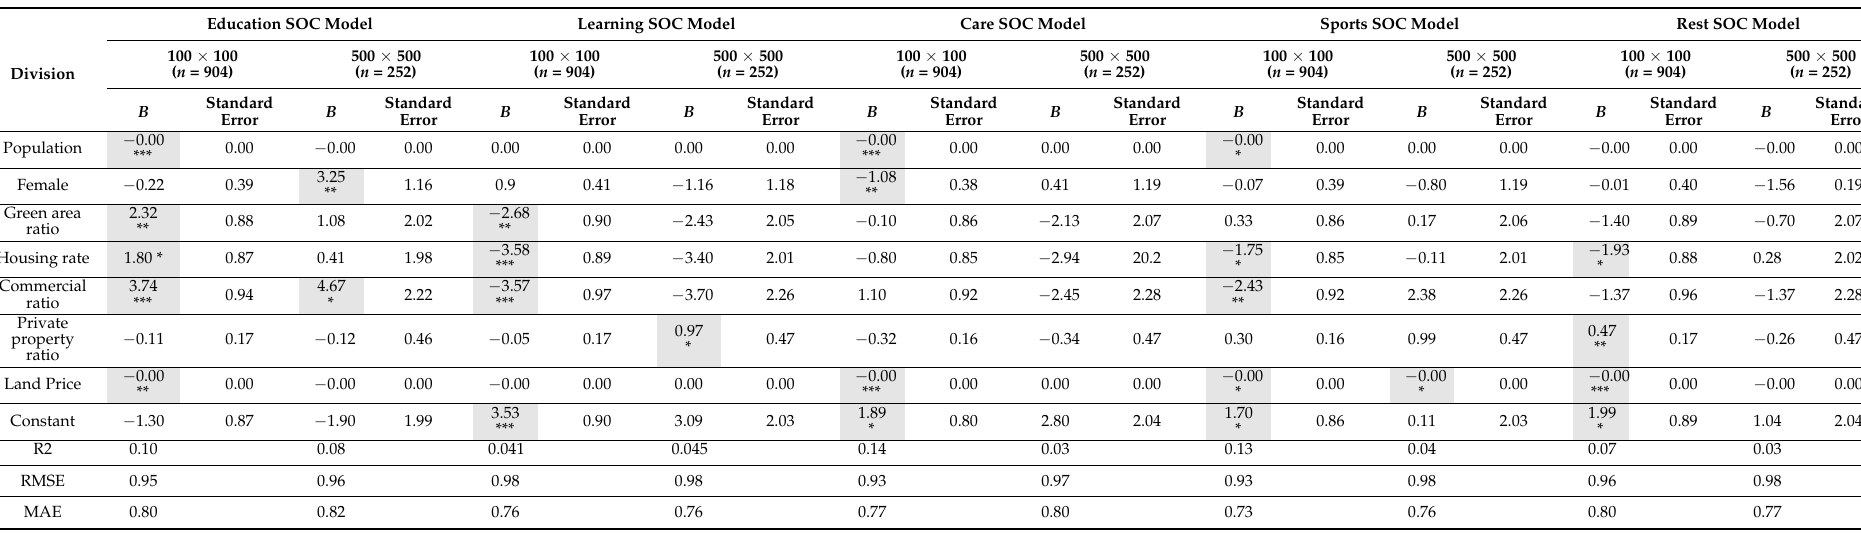
Table 5. Living SOCs (i.e., Education, Learning, Care, Sports, and Rest). Comparison of the rating analysis models: Regression analysis with the root mean of squared error (RMSE) and mean of absolute error